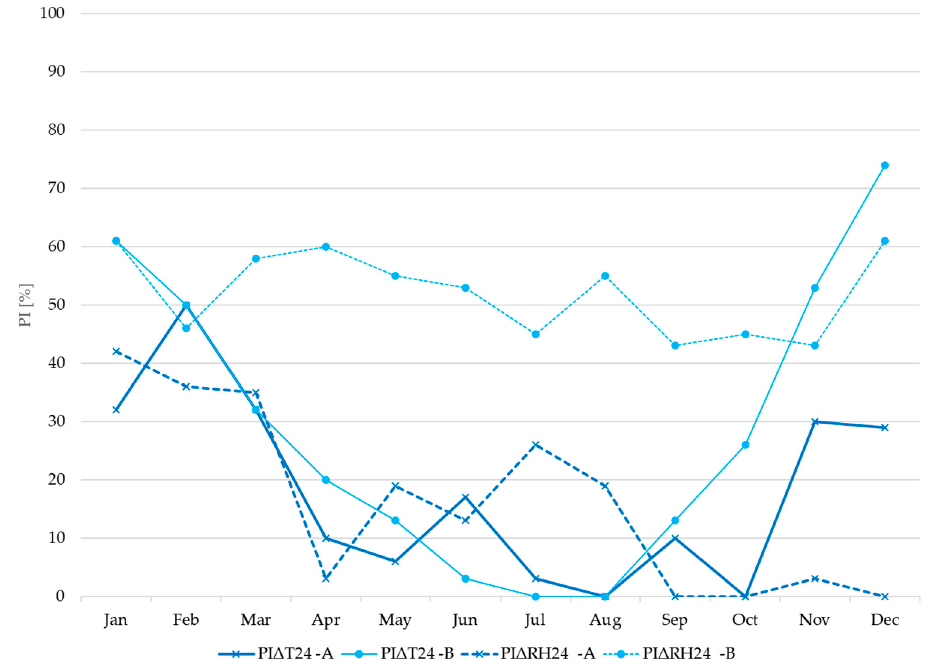
Figure 10. PI monthly values of hygrothermal parameters daily variation for position A (Lungarno) and B (Ponte Vecchio) in 2017.